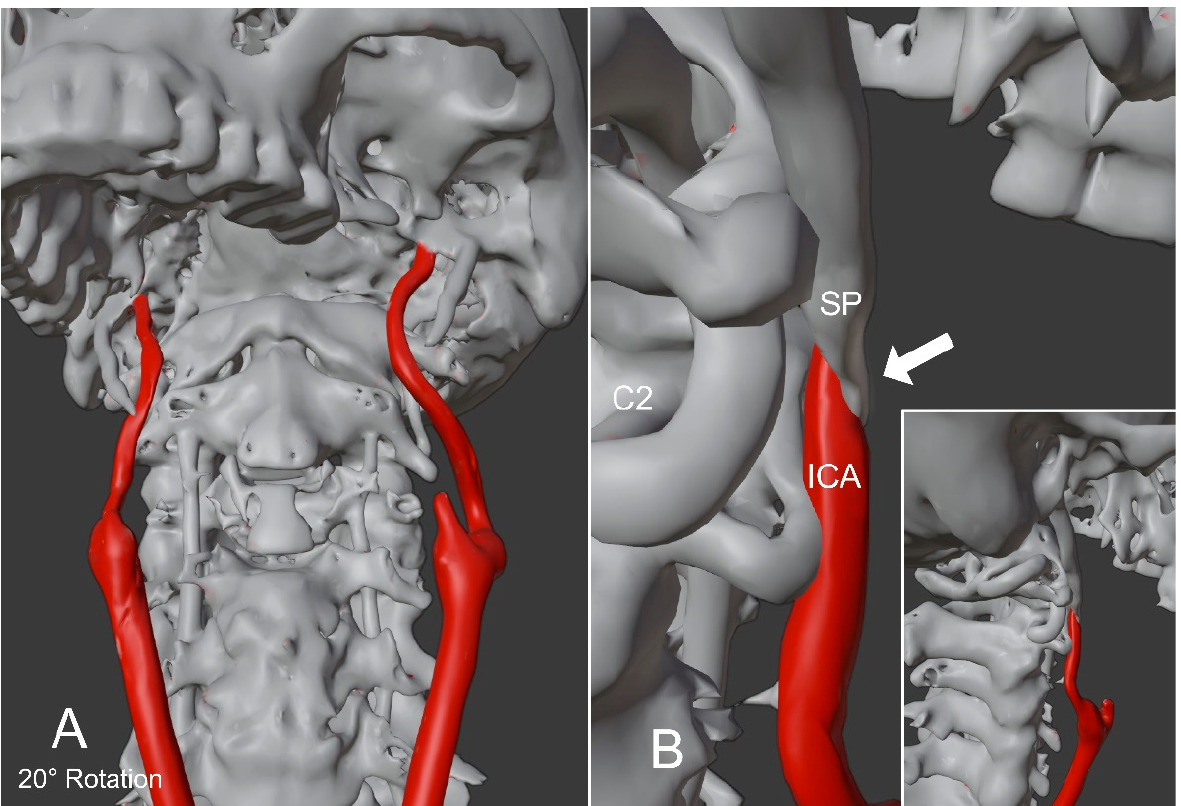
Figure 3. Patient with Eagle Syndrome in a right rotation of the head. ( A , B ) show a 3D reconstruction model in a 20° right rotation of the head. The model was created from the rest position CTA of the head and neck by applying a virtual 20° right rotation of the head. The right styloid process impinges the ipsilateral internal carotid artery tightening its caliber (arrow in ( B )). The 3D recon- struction model has been created from the rest position CTA of the head and neck. The enclosed image in ( B ) represents a postero-lateral perspective with a zoomed-out view. SP = Styloid process; ICA = Internal carotid artery; C2 = C2 Vertebral body.